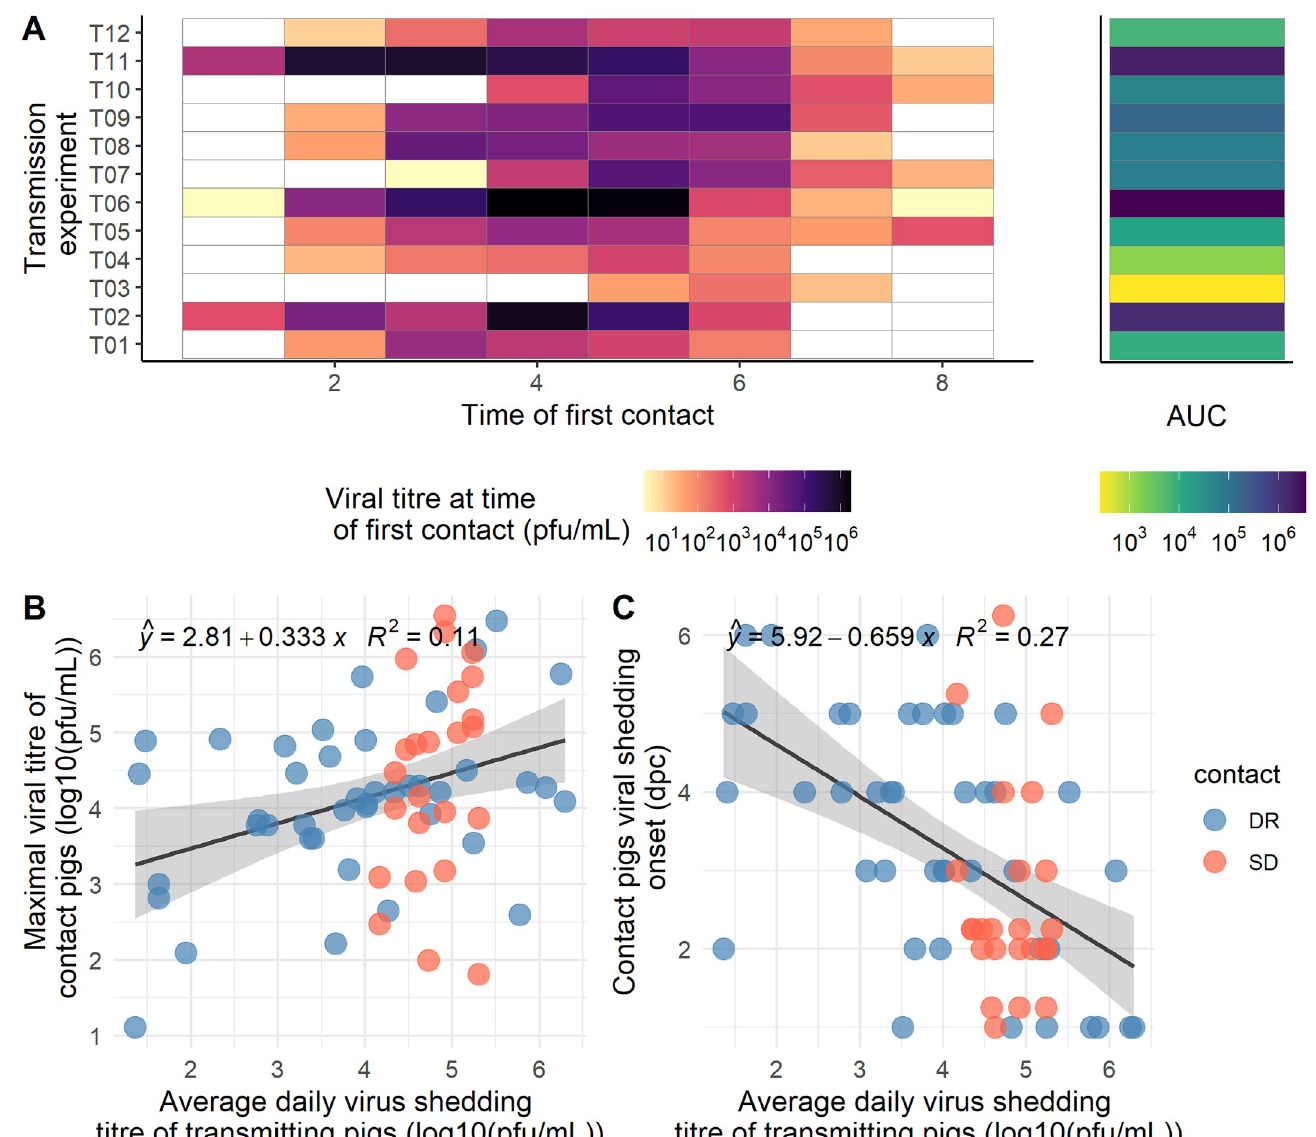
Fig 4. Transmission events and contact shedding. A. Each row represents a transmission experiment. The color of the tiles from the main panel represent the viral titre of the contact donor pig at the start of the in contact period. The side panel represent the corresponding area under the curve (AUC) in log scale. Transmission experiment T03 was excluded due to the presence of antibody in the contact donor pigs at the start of the experiment. B. Contact pig maximal viral titre vs. average daily virus shedding of parent pigs. C. Contact pig viral shedding onset vs. average daily virus shedding of parent pigs. SD and DR stand for Seeder- Donor and Donor-Recipient contact,